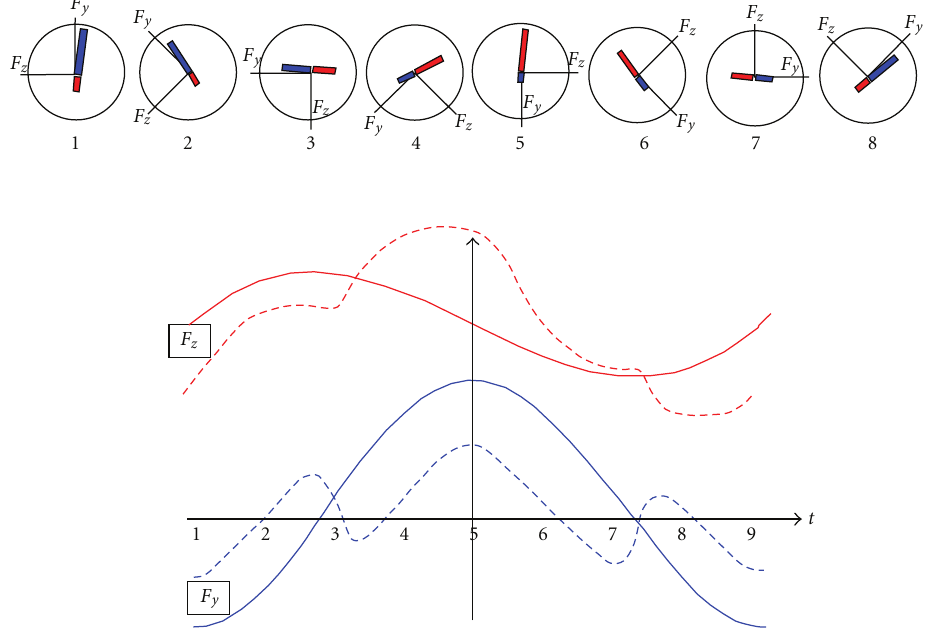
Figure 17: Scheme of the qualitative evolutions of F y (blue curve) and F z (red curve) during a single rotation of the inducer.